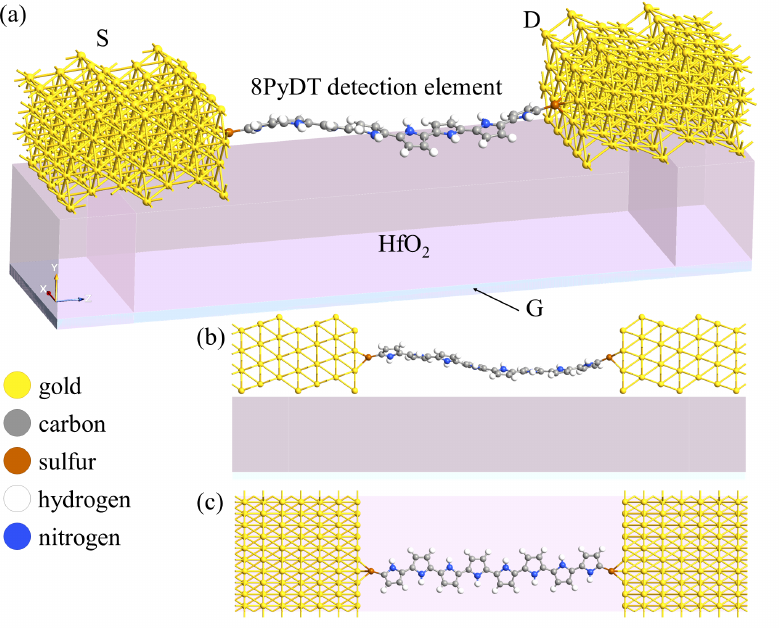
Figure 1. ( a ) 3D view of the structure of the proposed Au-8PyDT MolFET SMS; ( b ) side view; ( c ) top